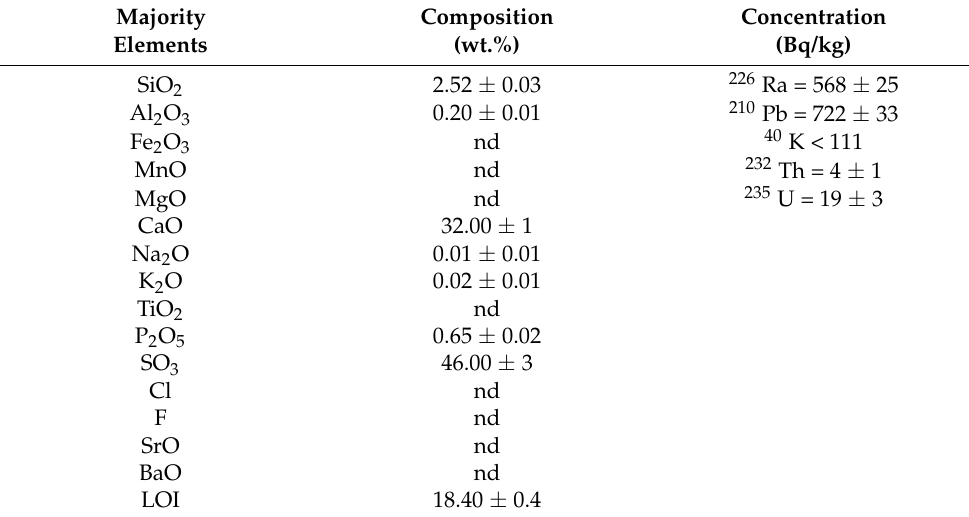
Table 1. Major chemical components and traces of the phosphogypsum sample. The X-ray fluores- cence (XRF) data was normalized to the calcined mass. Uncertainties are given as standard deviations. Average activity concentrations in Bq/kg of the different radionuclides